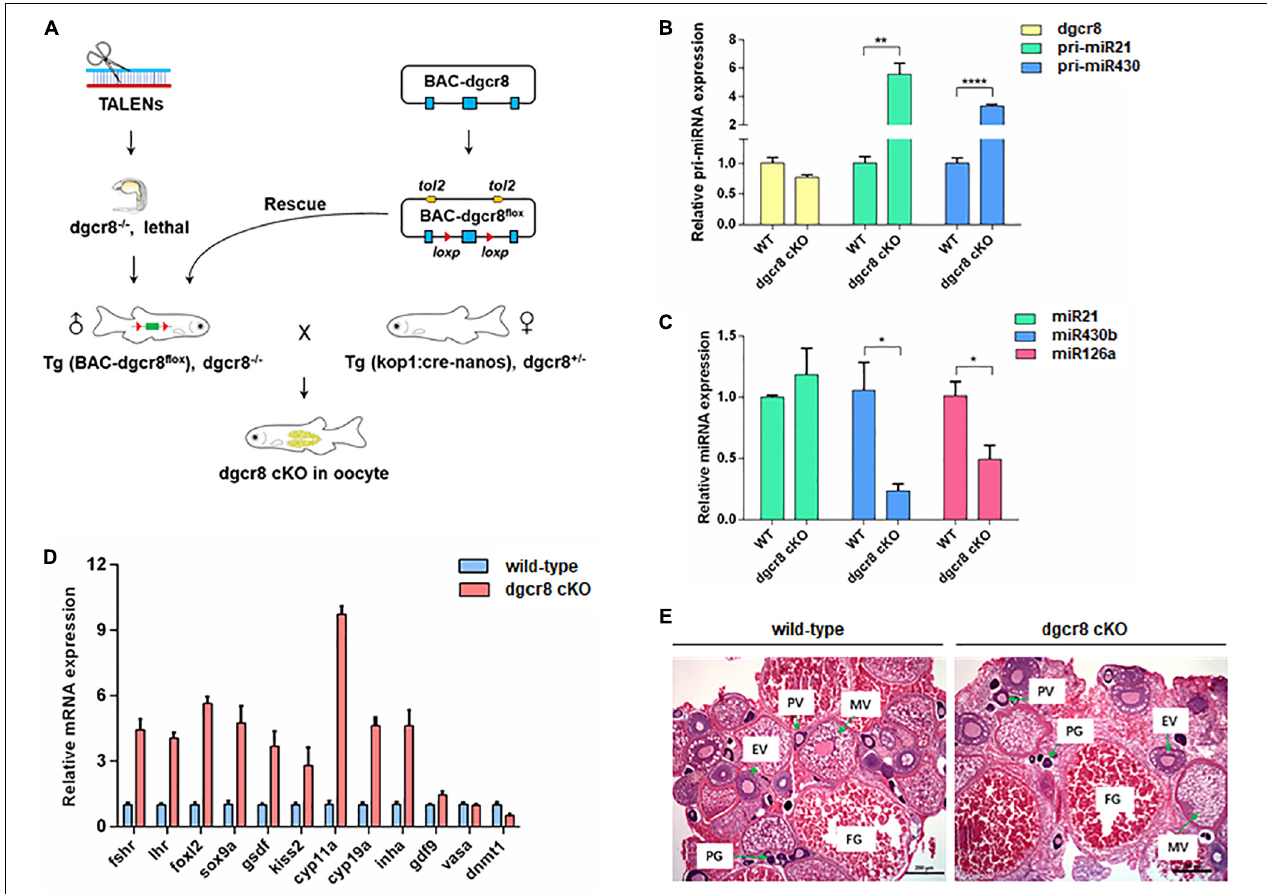
FIGURE 1 | Germline specific dgcr8 deletion has no functional influence on gonad development. (A) A basic schematic diagram of generating dgcr8 germline conditional knockout zebrafish. (B) Real-time analysis of the expression of dgcr8 mRNA and primary miRNAs in ovary of dgcr8 kop -cKO fish. (C) Real-time PCR analysis of the expression of mature miRNAs in ovary of dgcr8 kop -cKO fish. (D) Expression of germline markers in the ovary of dgcr8 kop -cKO. (E) Histology of ovaries in the wild-type and dgcr8 kop -cKO female zebrafish. * p < 0.05, ** p < 0.01, and **** p <